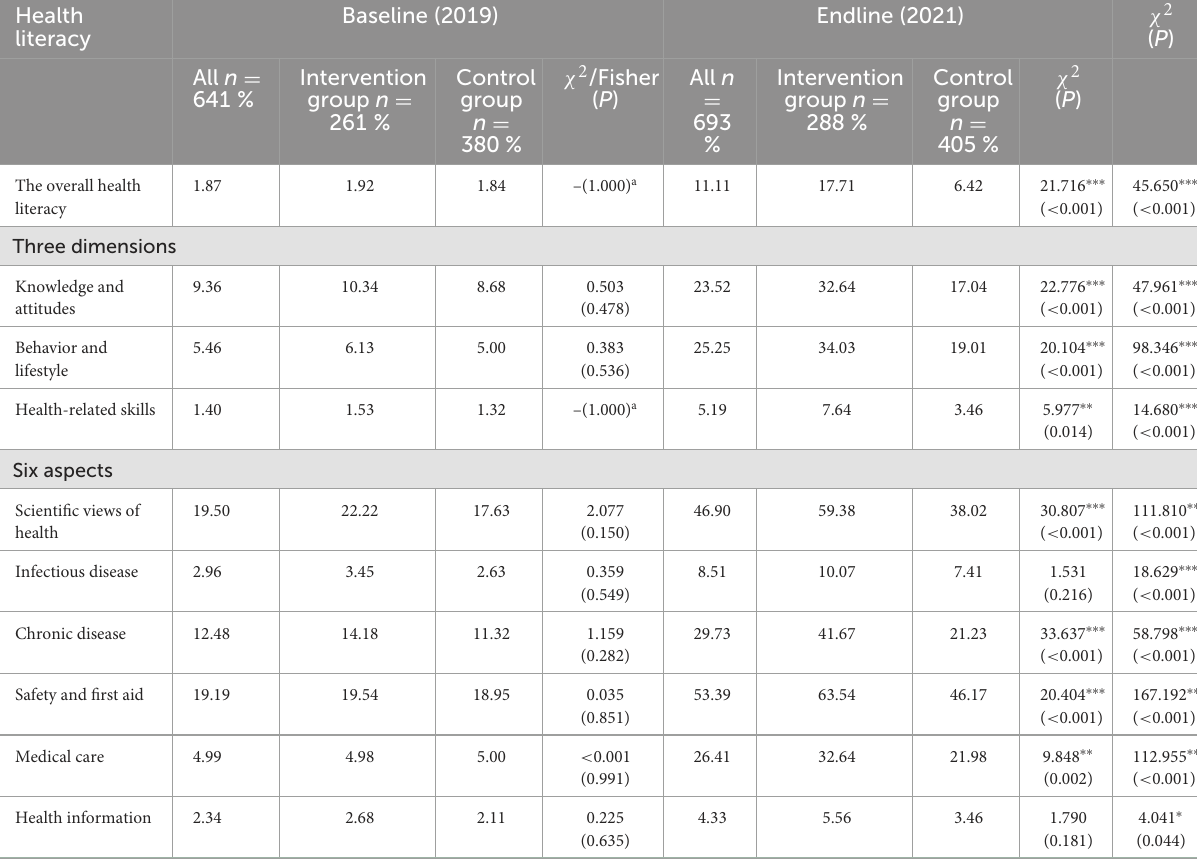
TABLE 3 Differences in health literacy levels between the intervention and control groups at baseline and endline. Health